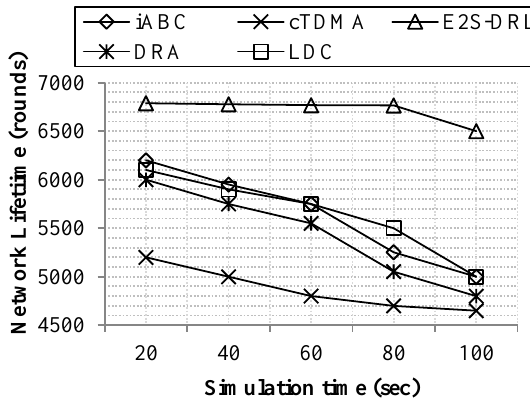
Figure 5. Comparison of network lifetime vs. simulation time.